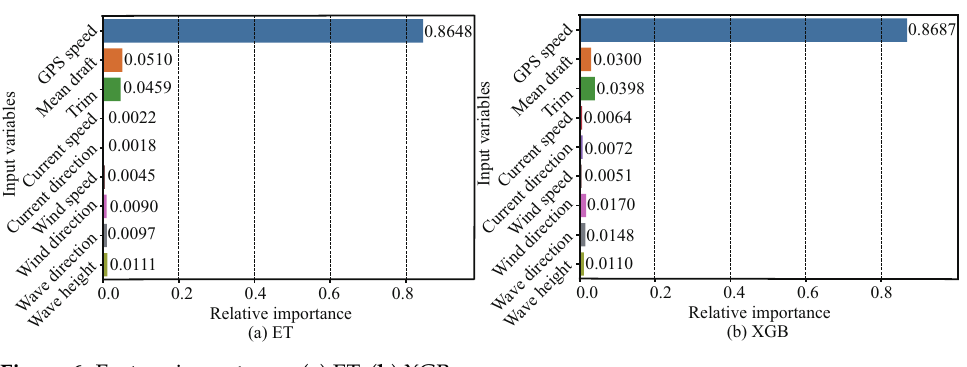
Figure 6. Feature importance: ( a ) ET. ( b )